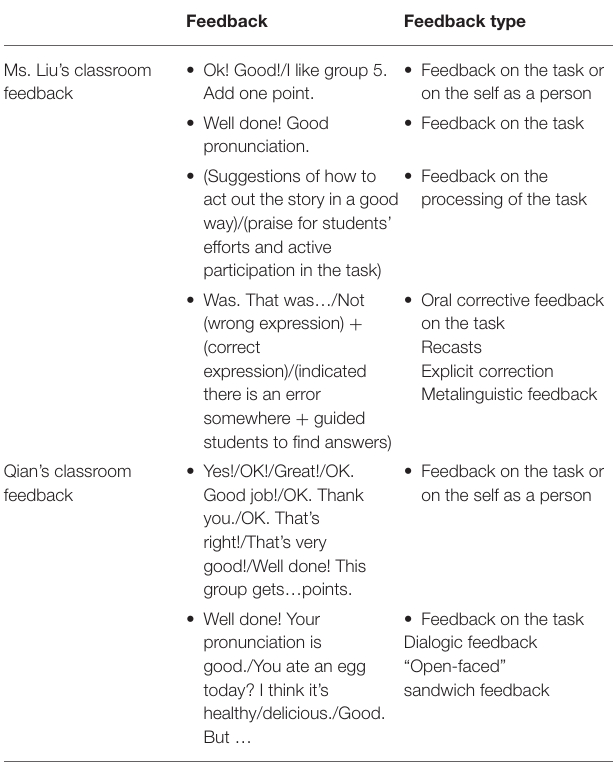
TABLE 4 | Oral feedback patterns of Qian and his associate teacher Ms.